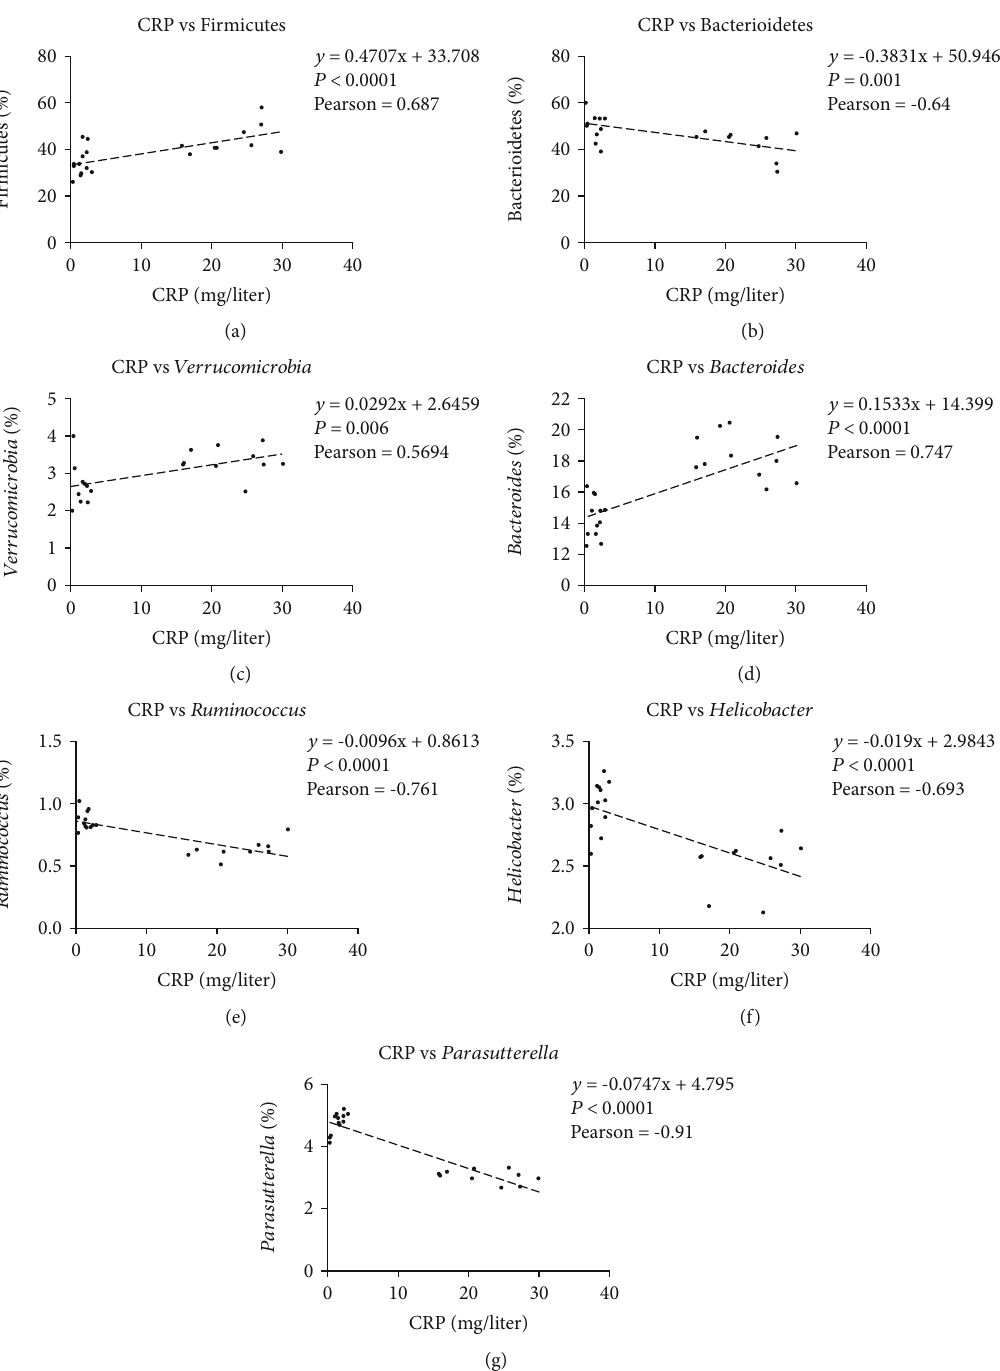
Figure 6: The association of microbiota with CRP. (a) Positive correlation between Bacteroidetes abundance and CRP; (b) Inverse correlation between Firmicutes and CRP; (c) Positive correlation between Verrucomicrobia and CRP; (d) Positive correlation between Bacteroides and CRP; (e) Inverse correlation between Ruminococcus and CRP; (f) Inverse correlation between Helicobacter and CRP; (g) Positive correlation between Parasutterella and